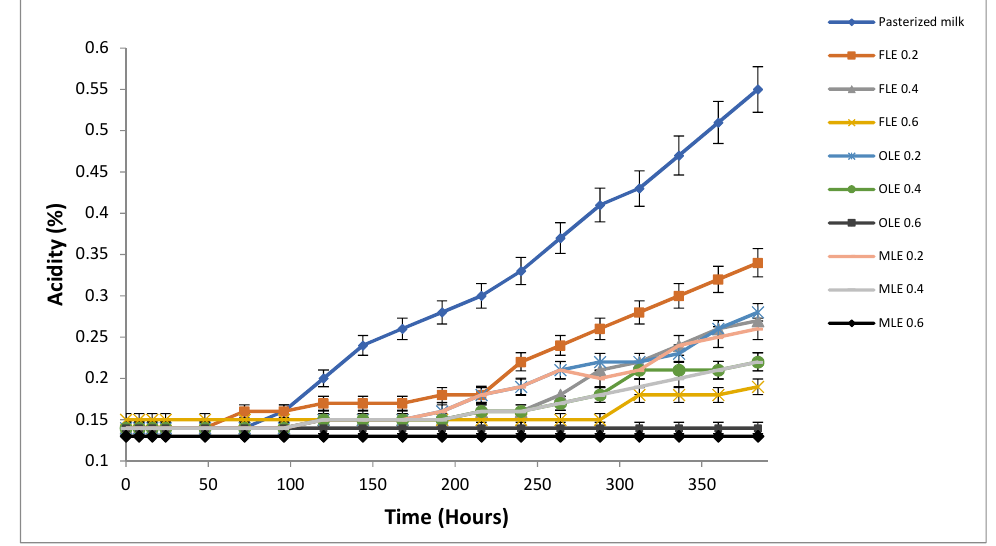
Figure 4. Observed average shelf stability of pasteurized buffalo milk enriched with FLE, OLE, and MLE, based upon titratable acidity at 5 °C for 16 days. Vertical bars show the standard error of the samples’ mean.